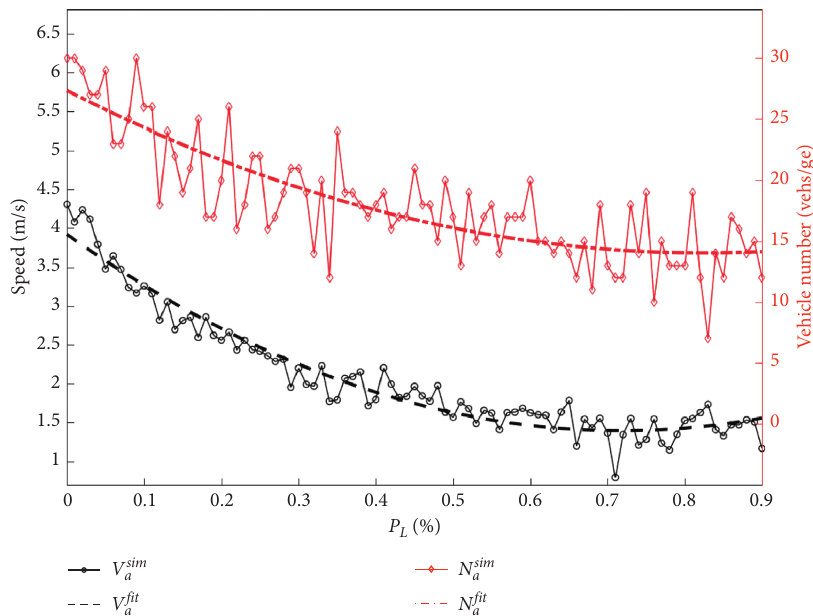
Figure 8: Diagrams under different P